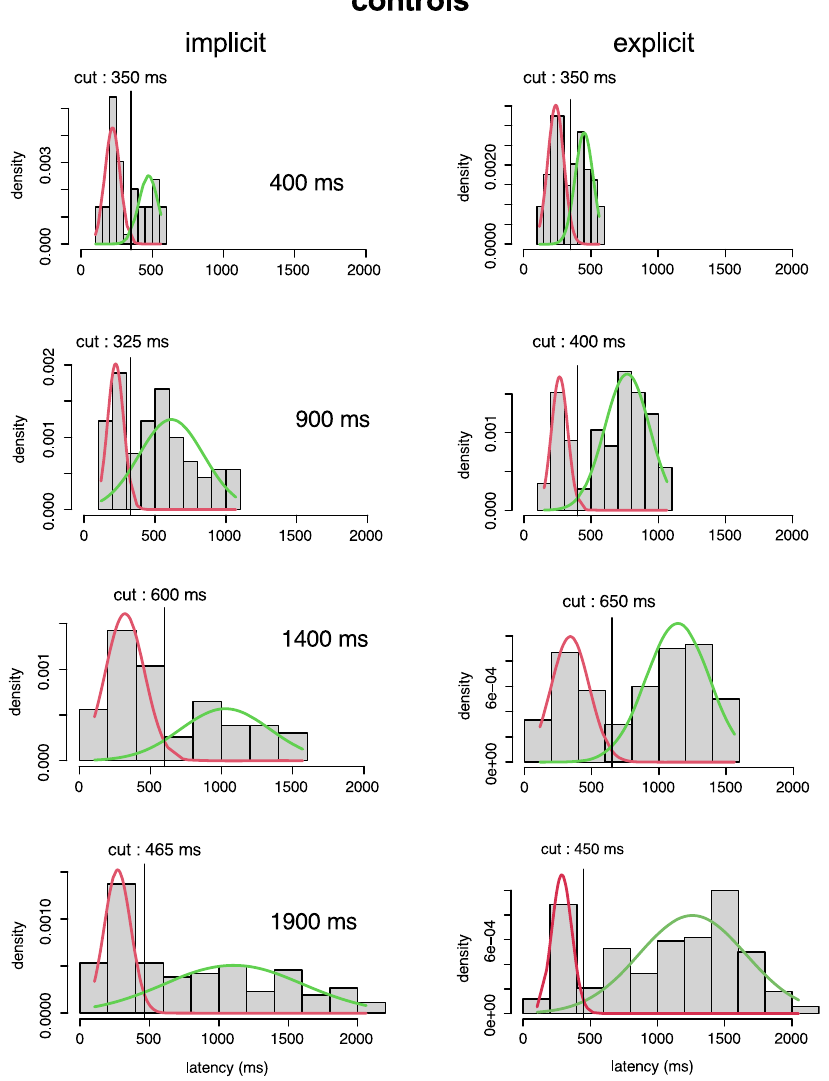
Fig. 4 Mixture model analysis. Saccadic latency probability densities in controls in the implicit (left) and explicit conditions (right) in controls as an example. Red curves: 1 st mode responses; green curves: 2 nd mode responses. The ‘ cut ’ between 1 st and 2 nd modes was deterministically placed at the intersection of overlapping Gaussian functions for the different durations